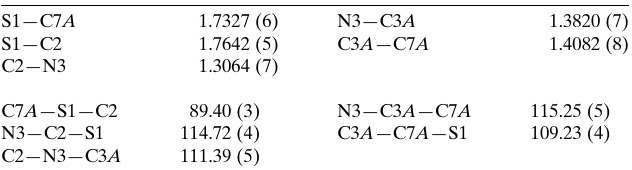
Table 1 Selected geometric parameters (A˚ , (cid:2) ).